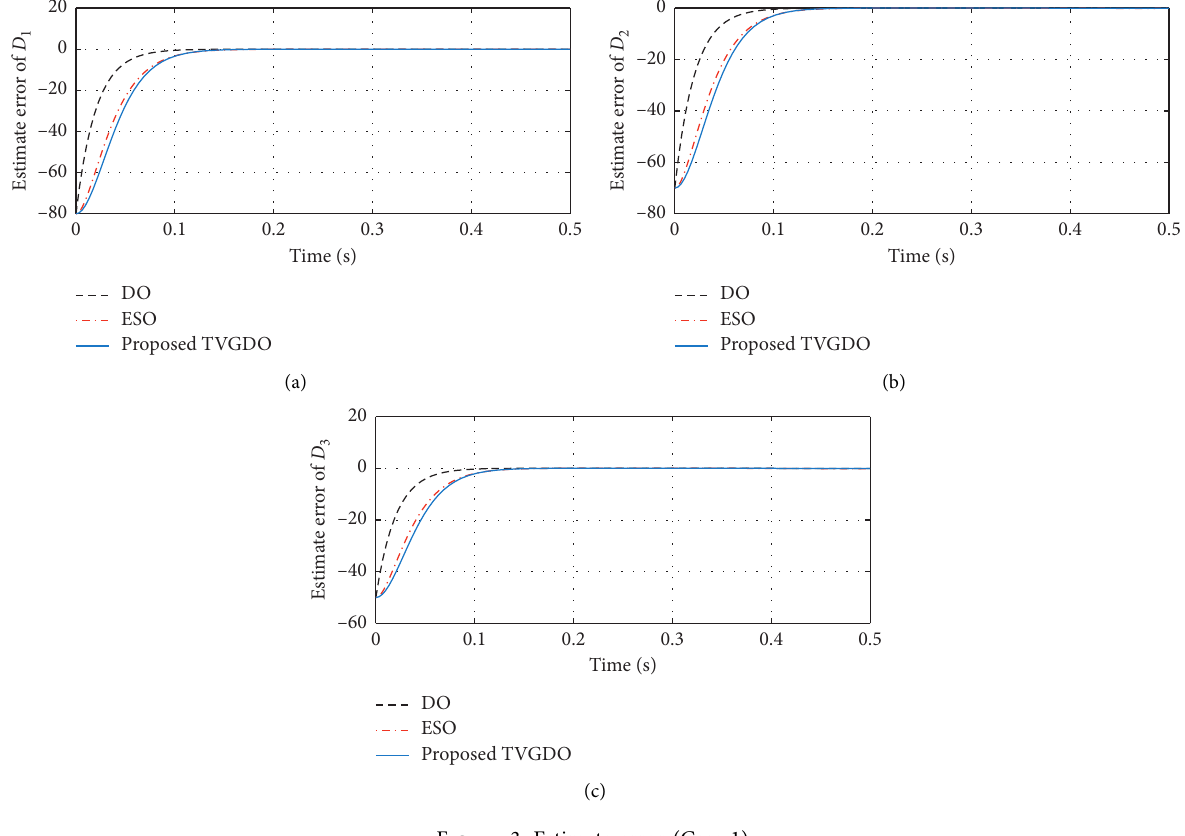
Figure 3: Estimate error (Case 1).